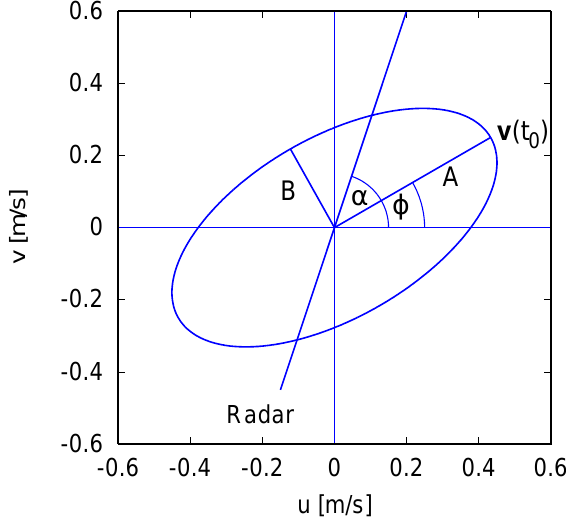
someofthe important